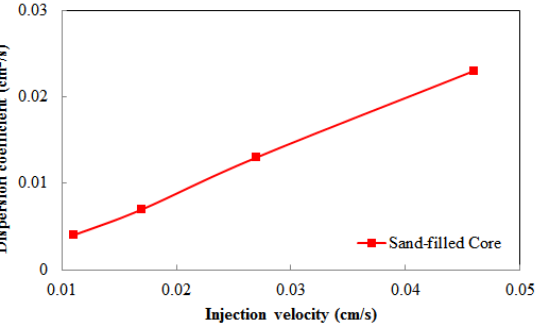
Figure 8. Dispersion coefficient versus injection (superficial) velocity in sand-filled cores.